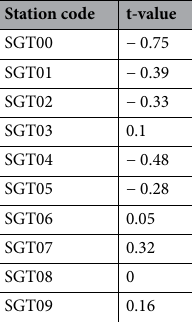
Table 3. Station/site correction coefficients to be used in Eq.